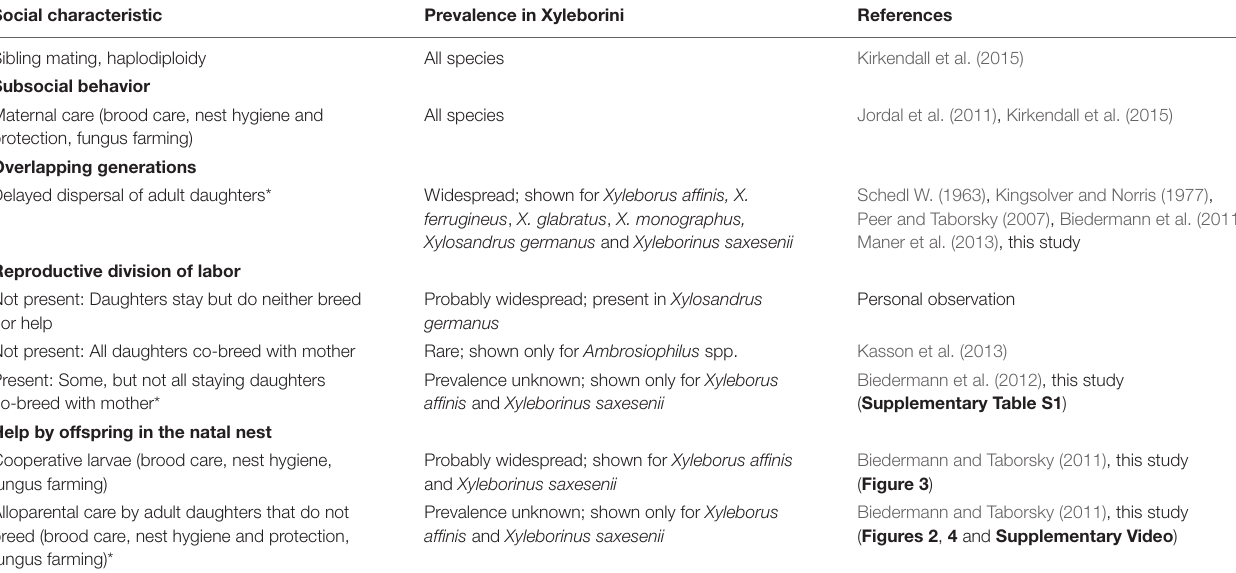
TABLE 2 | Overview of social traits found in the ambrosia beetle tribe Xyleborini (Curculionidae: